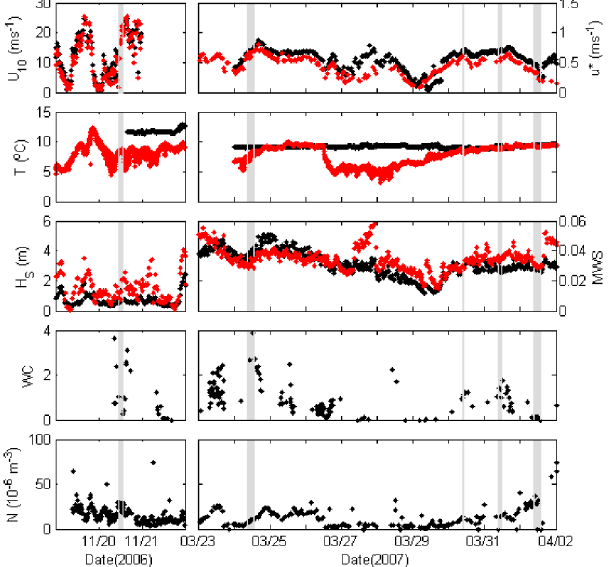
Fig. 2. Time series of mean conditions during the two cruises. Grey shading indicates the times of the buoy deployments. (a) 10m wind speed, U 10 (ms − 1 ) (black) and friction velocity, u ∗ (ms − 1 ) (red); (b) air temperature at ∼ 17m (red) and near-surface water temper- ature (black); (c) significant wave height H s (m) (black) and mean wave slope (MWS) (red); (d) mean half hourly whitecap coverage WC (%); (e) CLASP 28min averages of particle number concentra- tion (m − 3 ) (0.12 <R 80 <